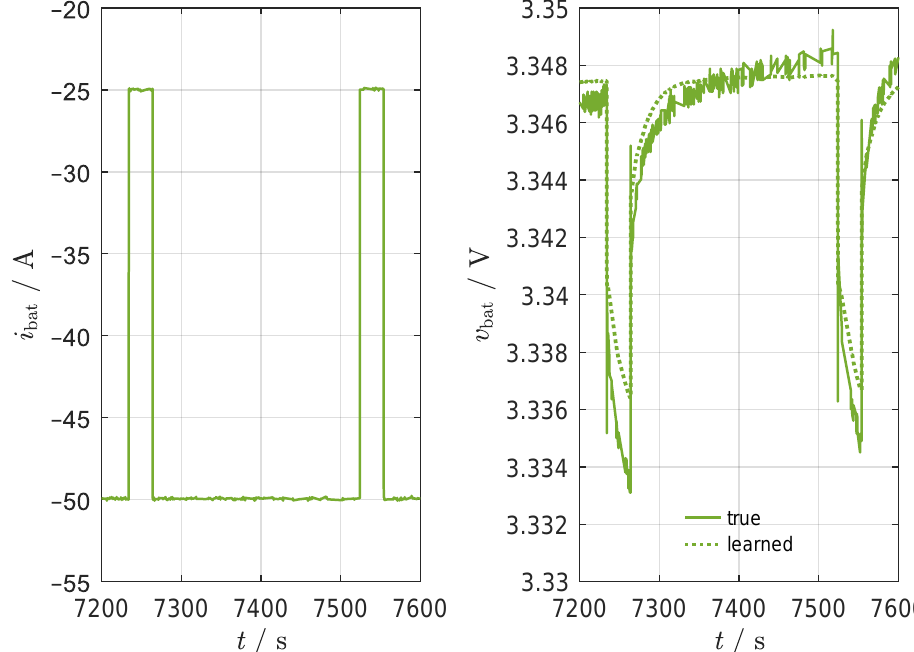
Figure 3. Simulation results using NODEs for grey-box modelling of a lithium-ion battery in compar- ison to experimental data at T = 25°C. The focus is on charging with a pulsed current at a medium SOC; ( left ): battery current versus time; ( right ): battery voltage versus